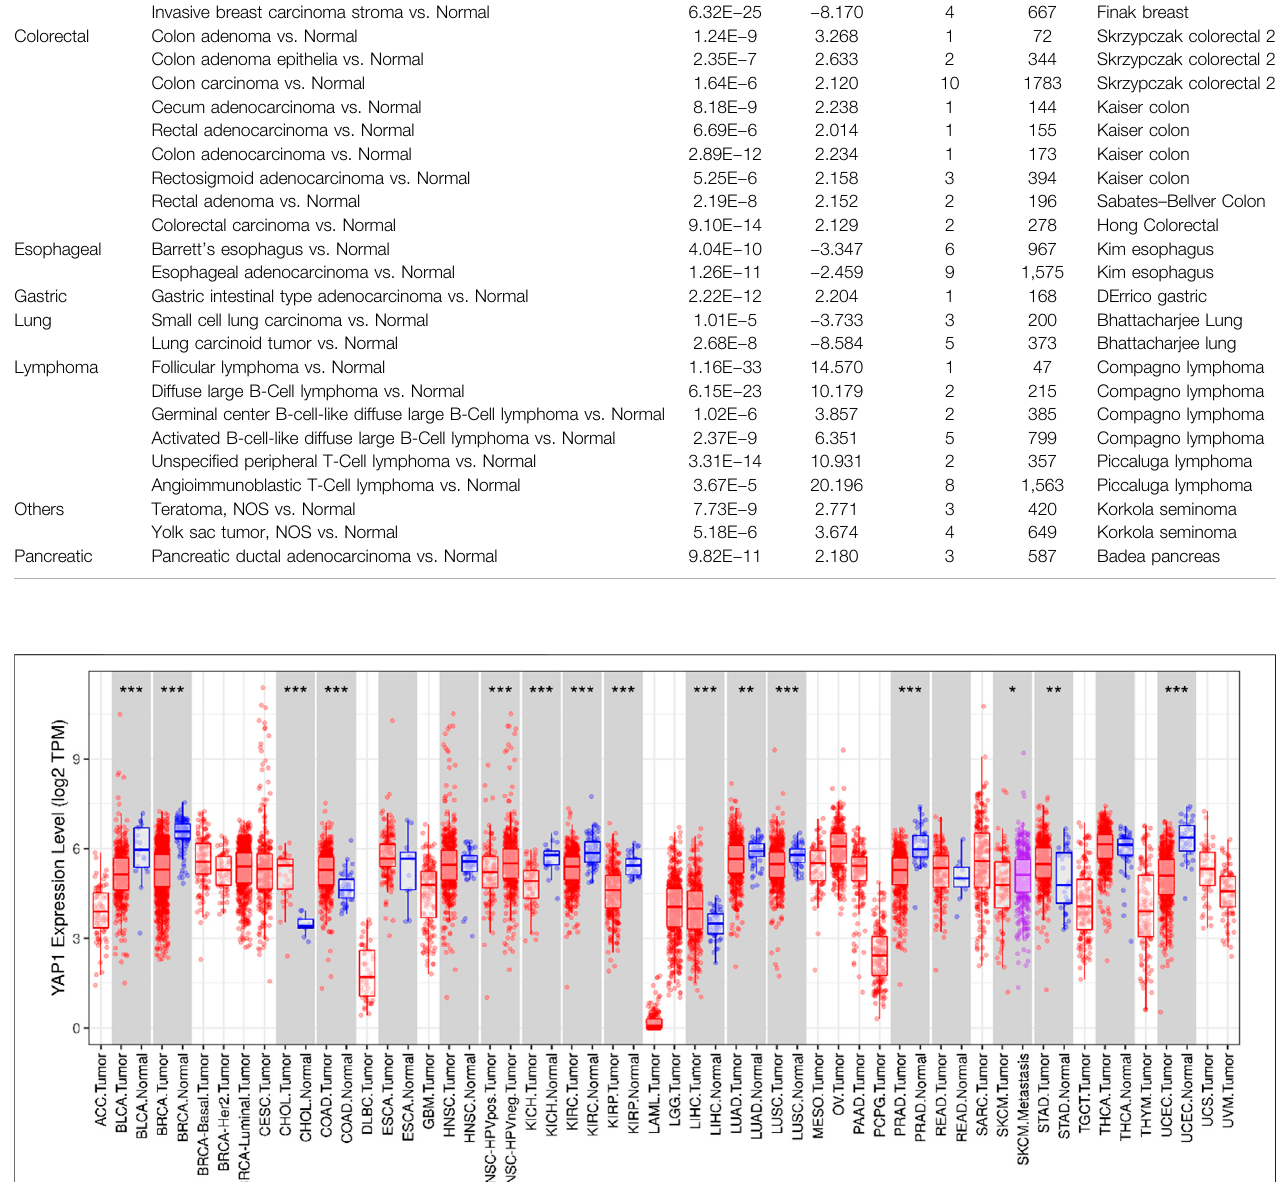
uterine corpus endometrial carcinoma (UCEC), and Uterine Carcinosarcoma (UCS). Differences between the expression of YAP1 in tumors and normal adjacent tissue samples are shown in Figure 3 .